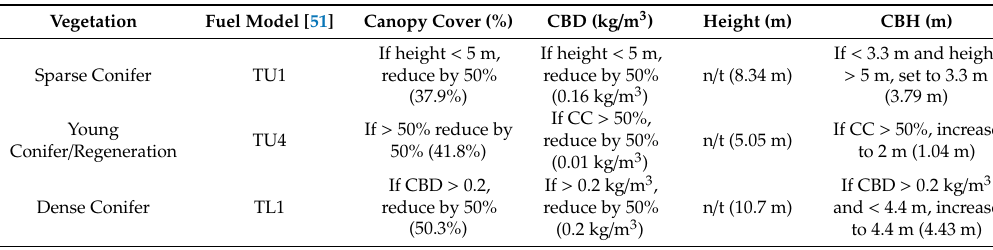
Table 2. Proposed fuel treatments (prescriptions). Numbers in parentheses denote the current average values of each variable. n / t denotes that no treatments were